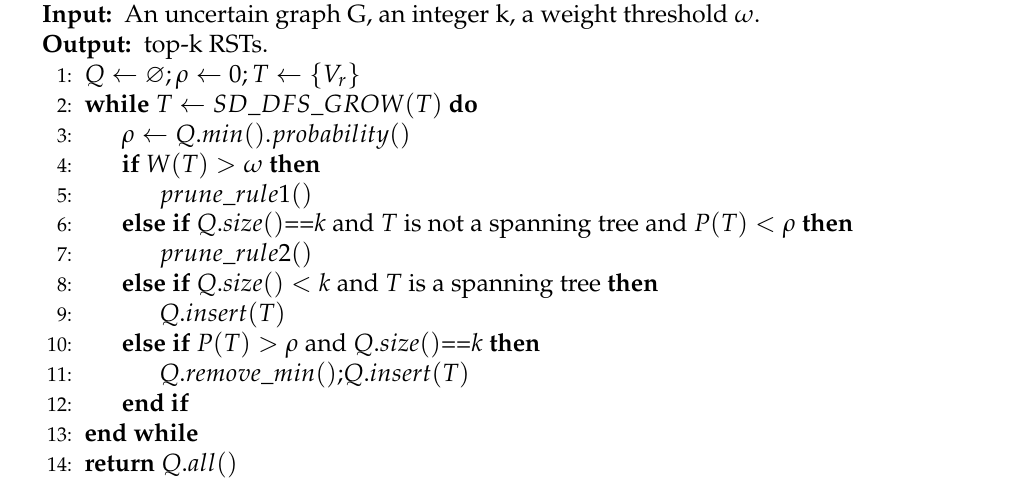
Algorithm 2. The DFS based tree-filtering algorithm,